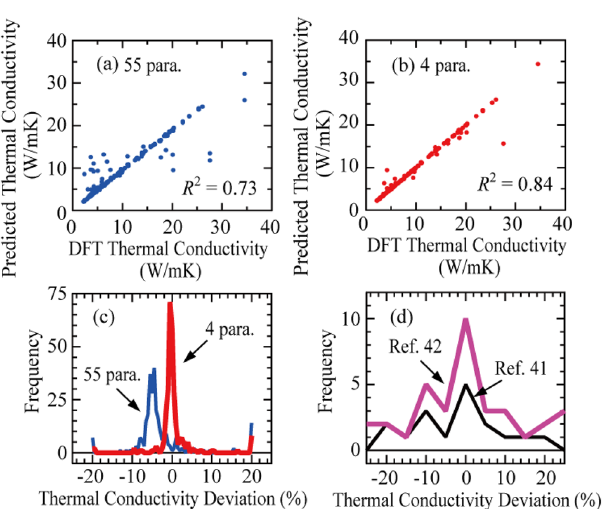
Figure 3. ( a ) R 2 for the ML model of multiple linear regression and boosted decision tree regression performed on the calculated lattice thermal conductivity. ( b ) Top 10 parameters of permutation feature importance for each parameter in the ML model of boosted decision tree regression. ( c ) Dependence of the number of features on the R 2 evaluated by the wrapper Method with backward feature elimination.